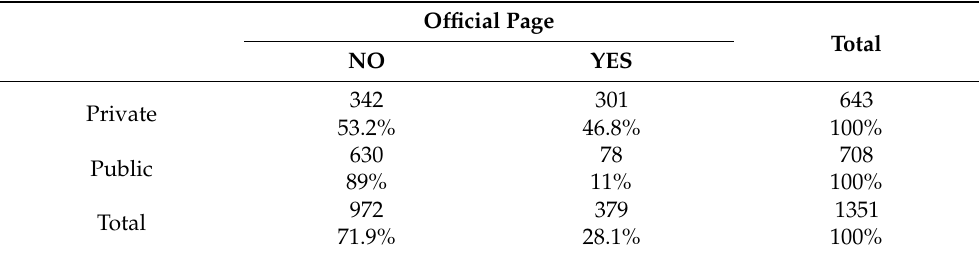
Table 1. Contingency table and chi-square test.